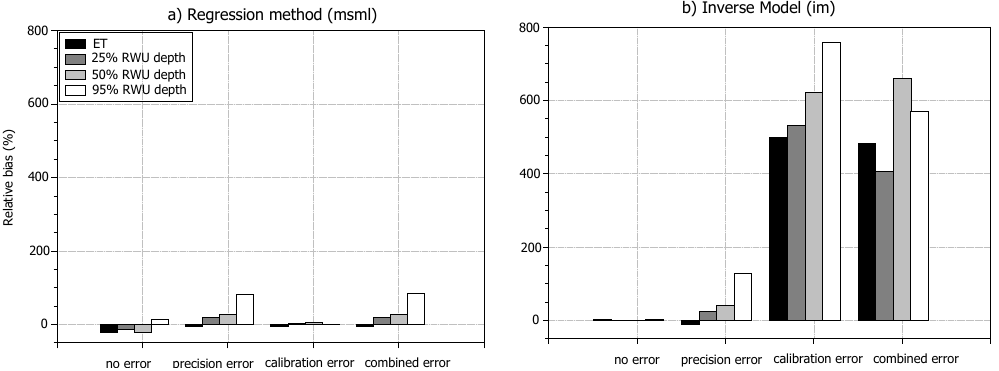
Figure 6. Comparison of the mean relative bias between synthetic and predicted values of evapotranspiration and the mean depths where 25, 50, 90% of water extraction occurs for soil moisture time series: without uncertainty (no error), precision uncertainty (precision error), calibration uncertainty (calibration error) and precision and calibration uncertainty (combined error) for the msml regression (a) and the im (b)